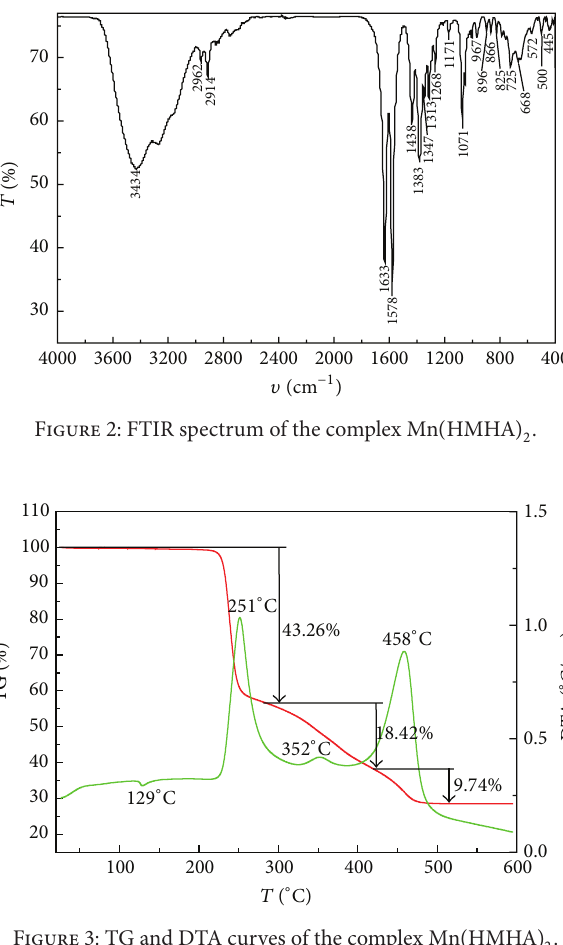
Figure 3: TG and DTA curves of the complex Mn ( HMHA ) 2